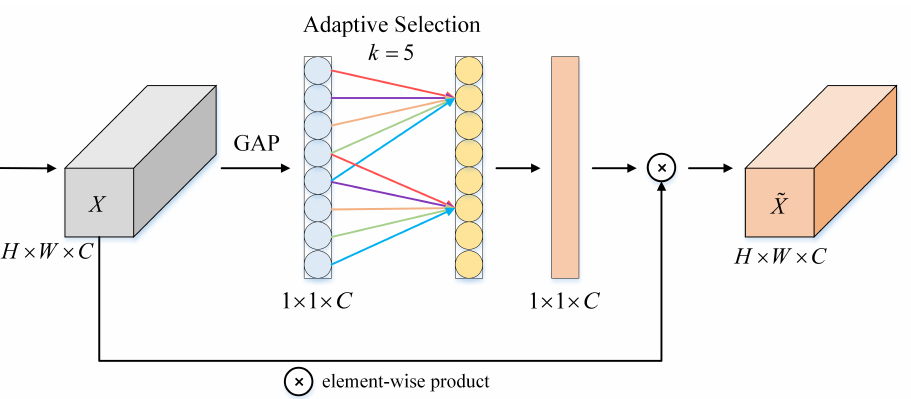
Figure 28. Efficient Channel Attention (ECA)